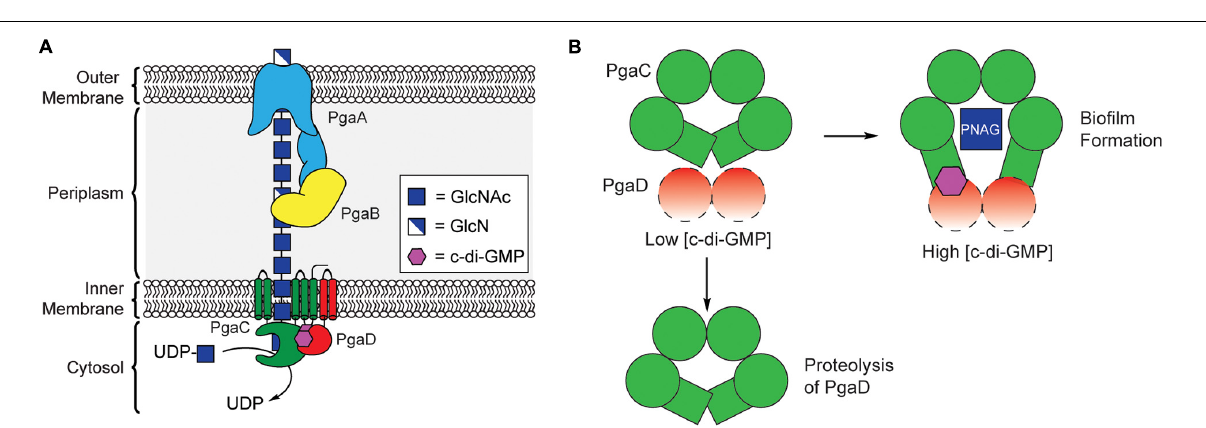
FIGURE 5 | C-di-GMP regulates PNAG biosynthesis through stabilization of the PgaCD complex. (A) Organization of the biosynthetic machinery for PNAG biogenesis in E. coli . (B) A proposed model for allosteric activation of the PgaCD complex by c-di-GMP. The binding of c-di-GMP (purple) to the membrane proximal region of PgaC (green) and PgaD (red) results in stabilization of an active complex. Under low c-di-GMP conditions PgaD loosely associates with PgaC and is susceptible to protease degradation resulting in the inactivation of